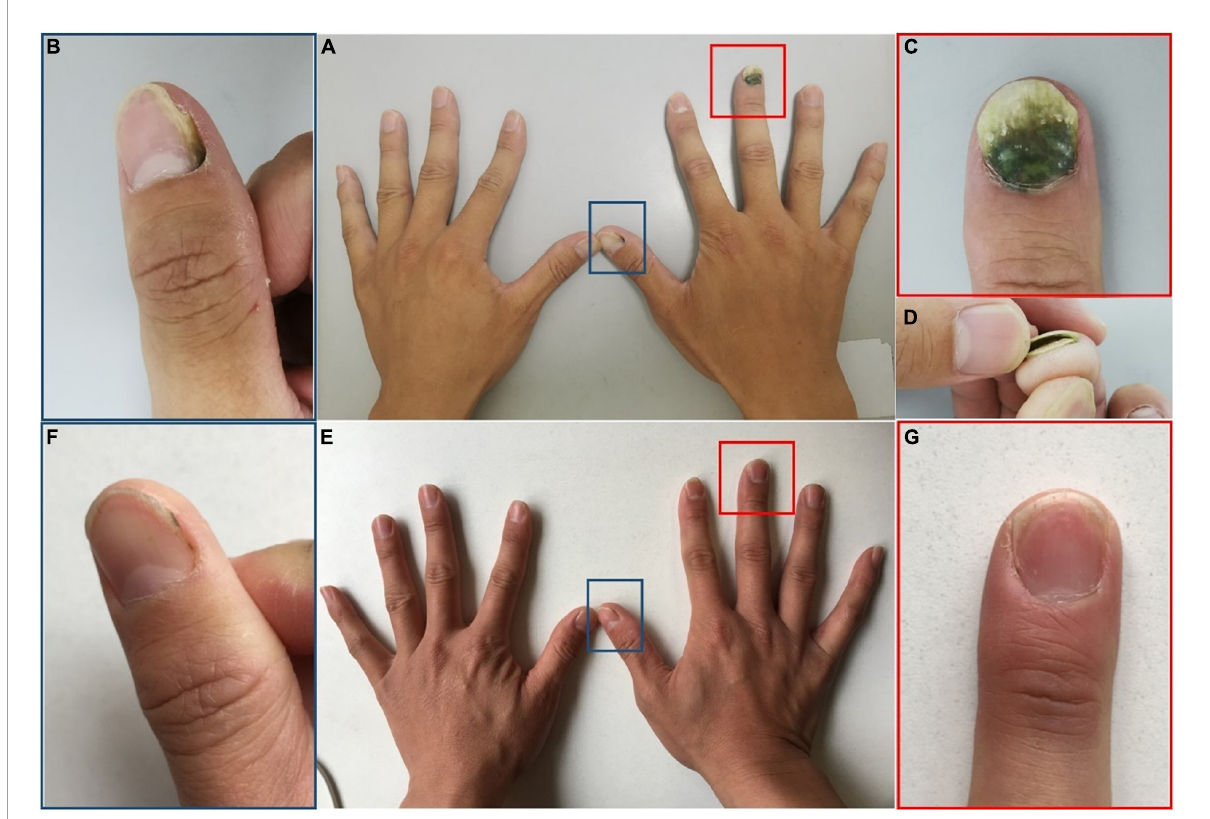
FIGURE2 Clinical image of Case 2. (A–D) Nail plate of a patient with occupation-related GNS at initial visit. (E,F) Subsided lesions at 6 months following chemical nail avulsion combined with topical antibiotic treatment. (B,C) Are partial magnifications of (A) . (D) Is profile image of (C) . (F,G) Are partial magnifications of (E) .